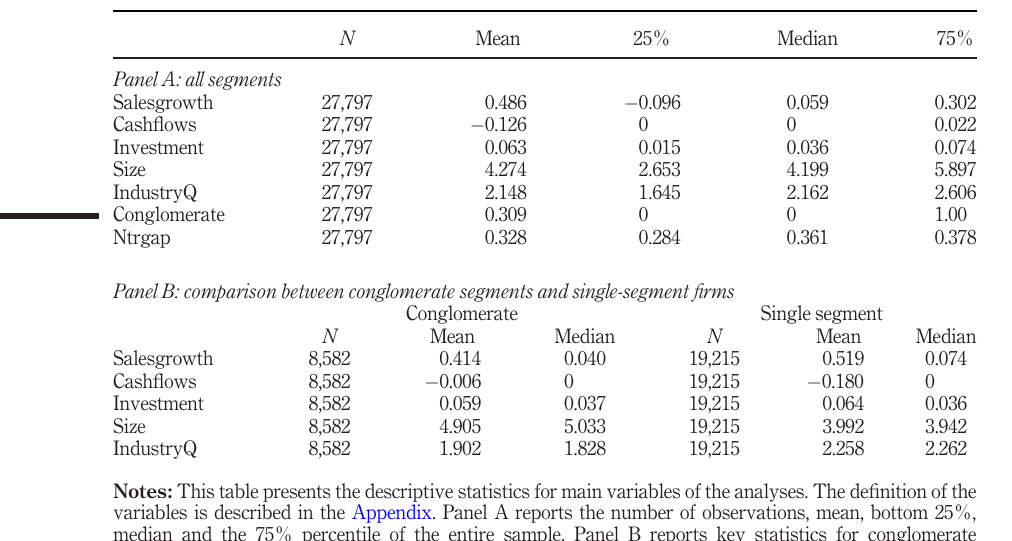
Table 2. Summary statistics